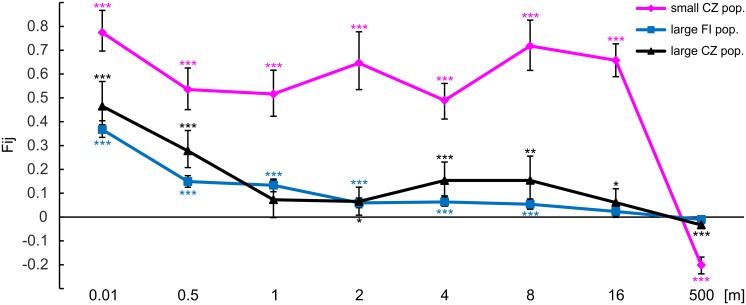
Spatial autocorrelation analysis based on microsatellite data.Populations of Crossocalyx hellerianus were divided into three categories (Table 1): small CZ pop., large FI pop., large CZ pop. The Nason’s kinship coefficients (Fij) are positioned along the X-axis at the mean pairwise distance within each distance class. Vertical bars show standard errors. Significance of average F values is marked as *** P < 0.001; ** P < 0.01; * P < 0.05.